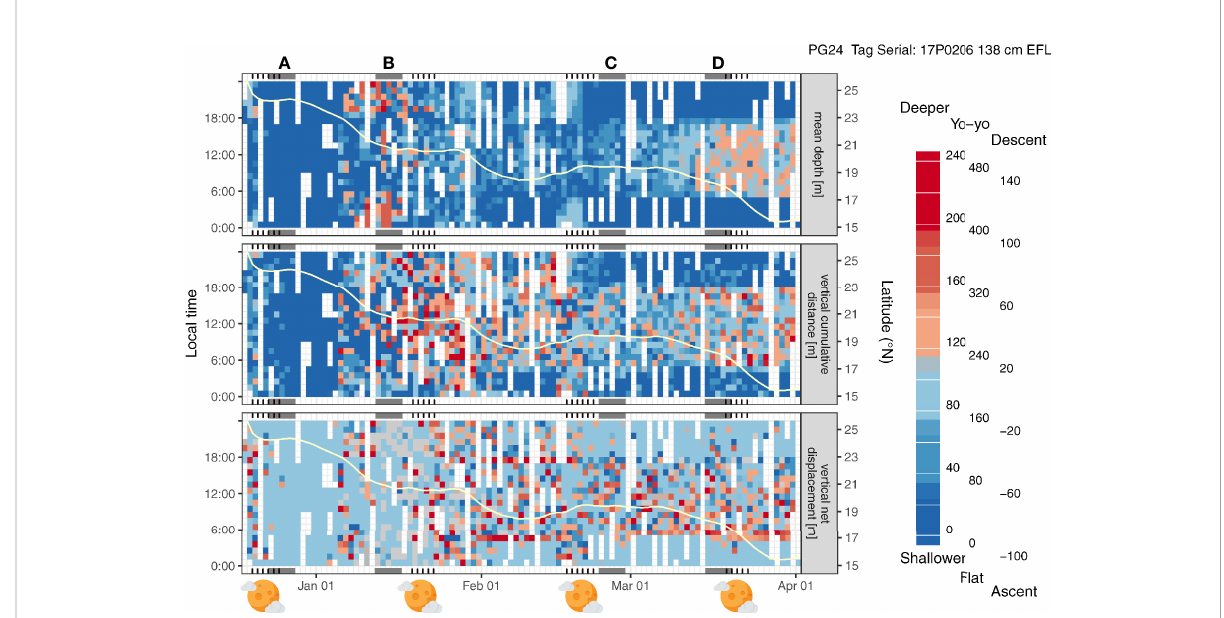
FIGURE 6 Vertical activity of striped marlin PG24. Hourly mean depth (top), vertical cumulative distance, Vdist (middle), and vertical net displacement, Vplace (bottom) are summarized through a 24-hours period (00:00-23:00 local time) for its tracked time at liberty (x-axis). False-color scale is shared by all three variables, but each has its own break values for mean depth (left), Vdist (middle), and Vplace (right). Labels added to the top and bottom of the color scale illustrate what each variable physically represents, e.g., deeper vs . shallower depth. Latitude of its track positions through time (x-axis) is shown on the secondary y-axis as a white trace. Grey bars along the x-axis denote the same time periods shown previously in Figure 4 : (A) 2018-12-23 to 2018-12-28, (B) 2019-01-12 to 2019-01-17, (C) 2019-02-23 to 2019-02-28, and (D) 2019-03-15 to 2019-03-20. Black ticks on the x-axis denote the dates in which over 95% of the moon was